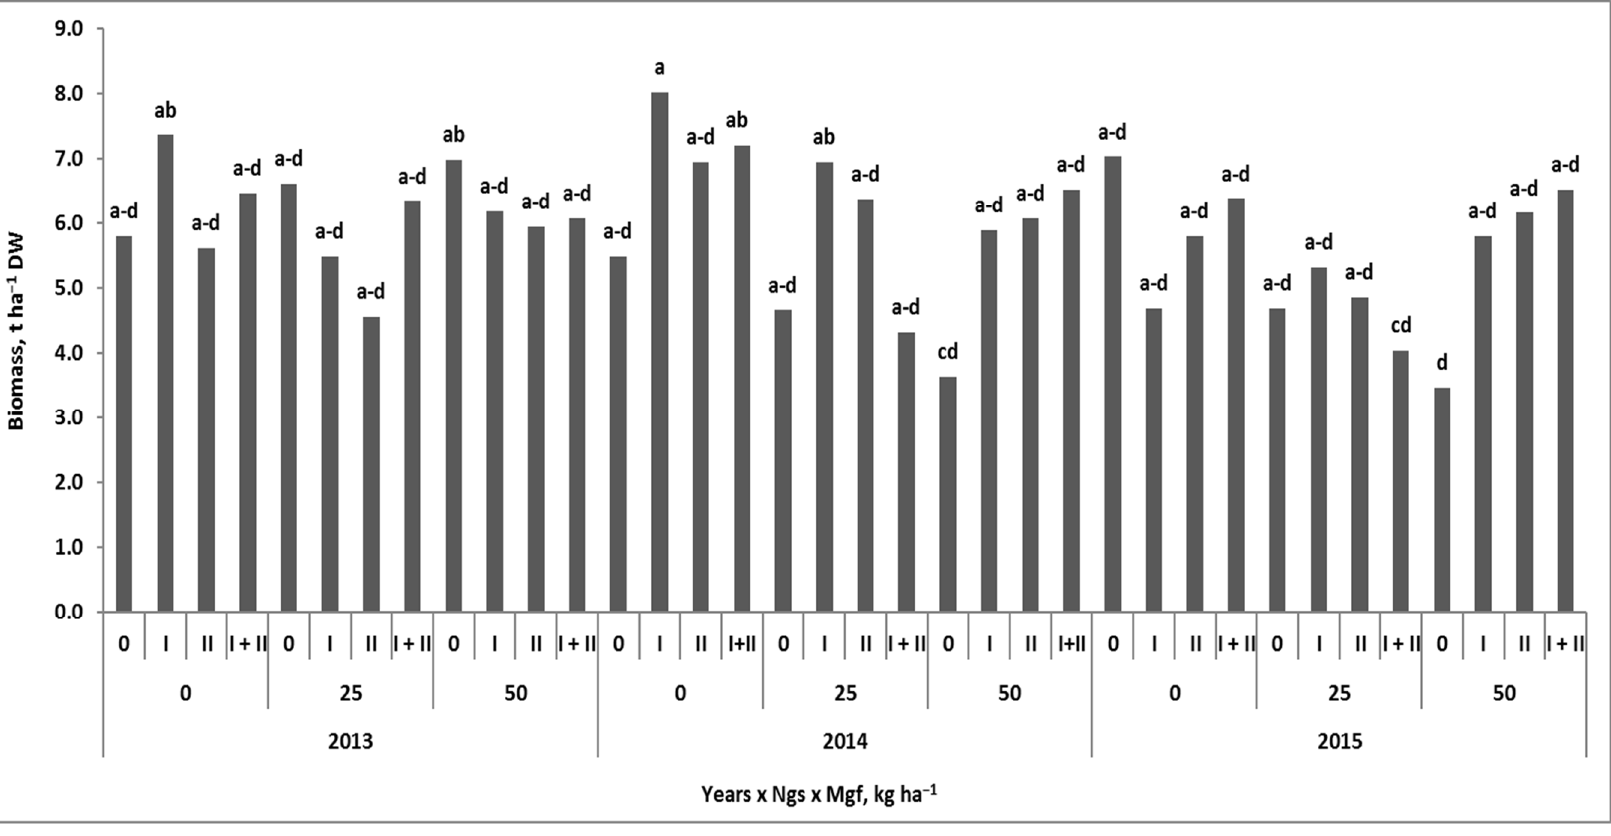
Figure 7. Effect of magnesium fertilization systems on the background of years on the current photosynthesis of winter wheat in the grain-filling period. Similar letters mean a lack of significant differences using Tukey’s test. Legend: Mgs, Mgf—soil and foliar Mg fertilization systems, respectively; I—BBCH 30; II—BBCH 49/50.